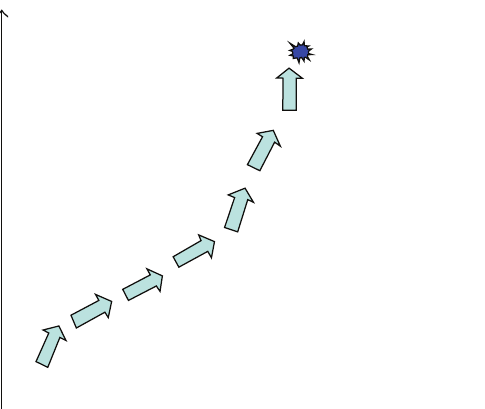
Figure 13: Mirchi plugin for TinyViz.